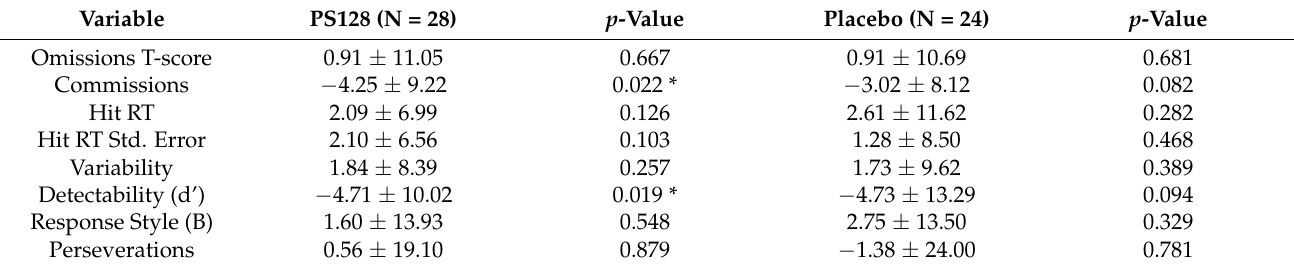
Table 5. The change of the parameters of CPT after treatment in the PS128 group and the placebo